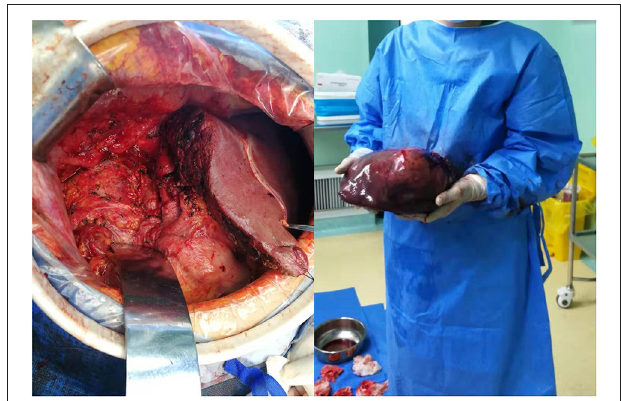
FIGURE 4 | Immunohistochemical expression. (A) HE staining; (B) Hepatocyte( + ); (C) Glypican-3 ( + ); (D) AFP ( + ); (E) CgA ( + ); (F) SYN ( + ); (G) Arginase-1 (–); and (H) KI-67.